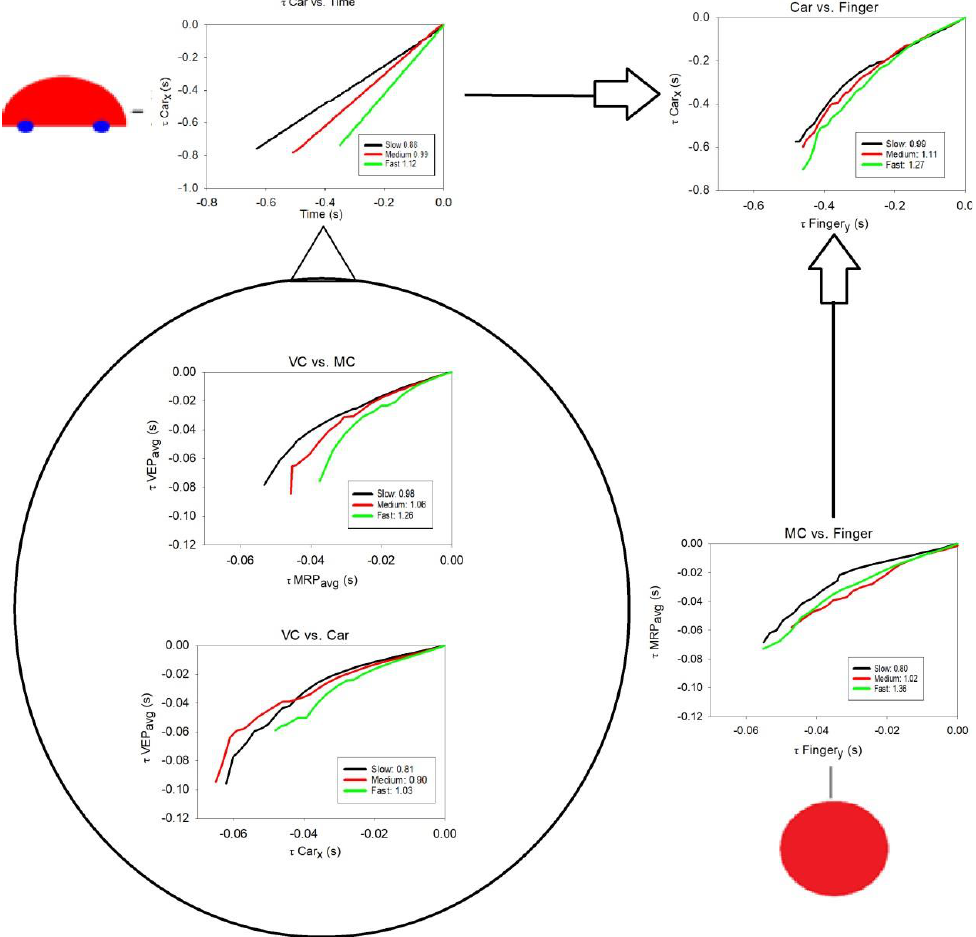
Figure 7. Overall τ -coupling results, depicting five grand averaged τ -coupling graphs overlayed on a task/head model that reflect the ecological scale and neural scale of the interception task. The graphs display the τ -coupling results of (1, top left ) car vs. time-to-collision, (2, top right ) car motion vs. finger movement, both representing the ecological scale, and (3, top graph in the head model) visual cortex (VEP) vs. motor cortex (MRP), (4, bottom graph in the head model) visual cortex (VEP) vs. car motion, and (5, bottom right ) motor cortex (MRP) vs. finger movement, with 3 – 5 representing the neural scale of the interception task. Each graph displays the average slopes for each τ -coupling constant k for the three different car speeds slow (black), medium (red), and fast (green). For details about the τ -coupling procedure, see [42].